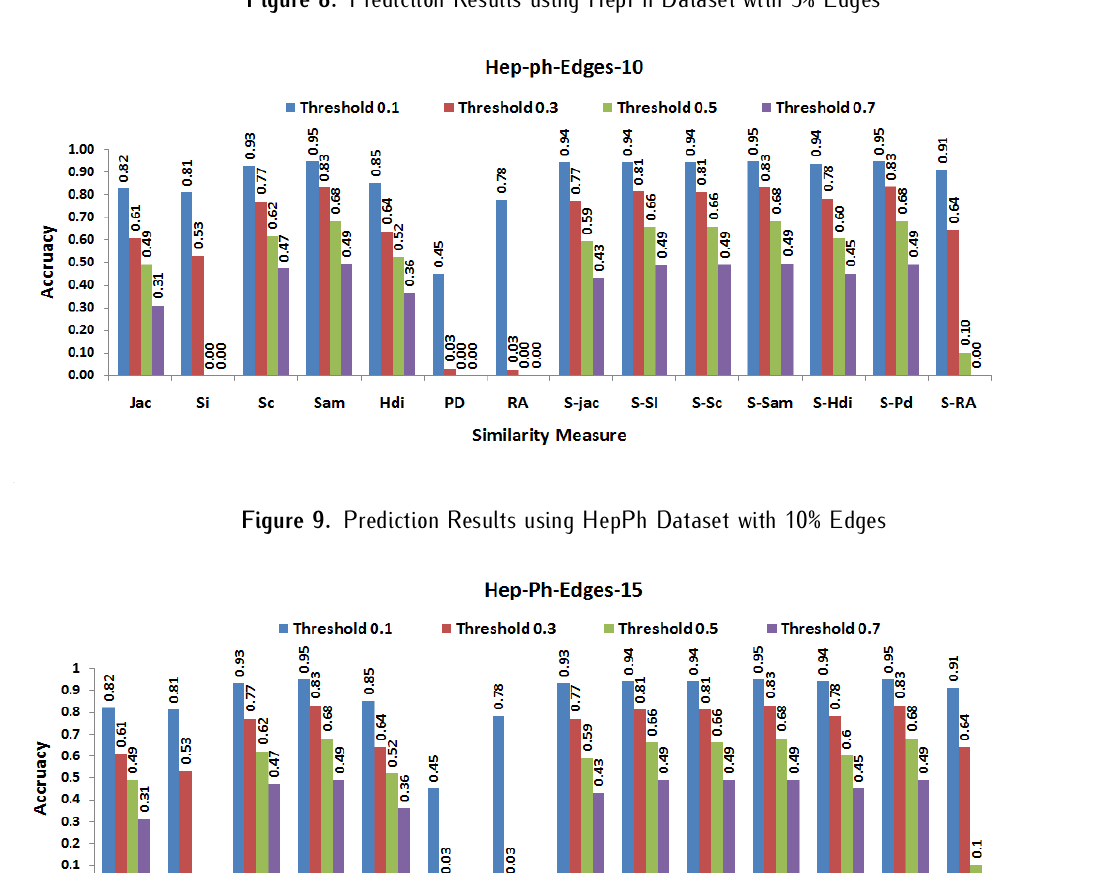
Figure 8. Prediction Results using HepPh Dataset with 5% Edges